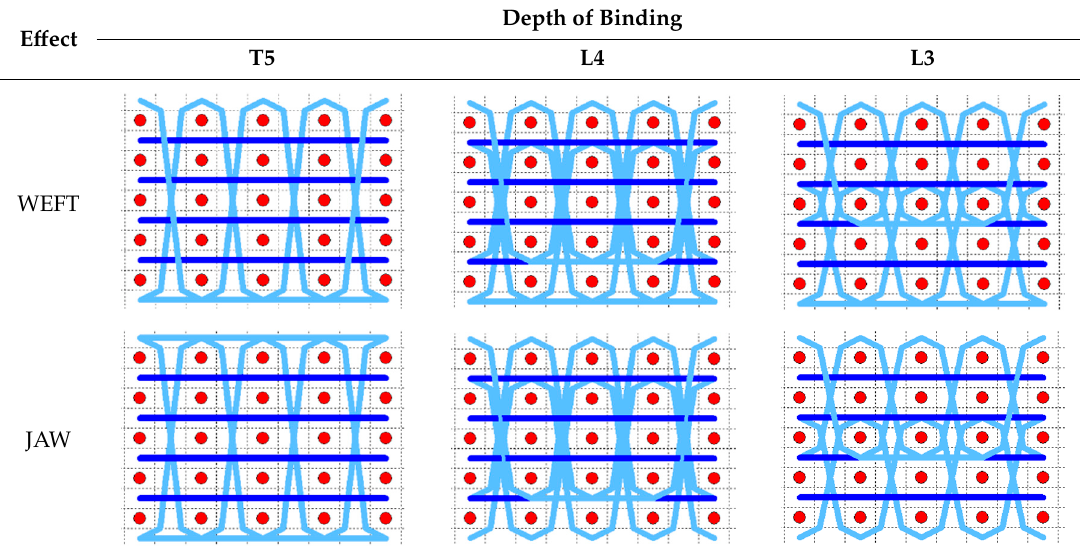
Table 1. Weft yarn cross section views of the six different 3D warp interlock architectures.